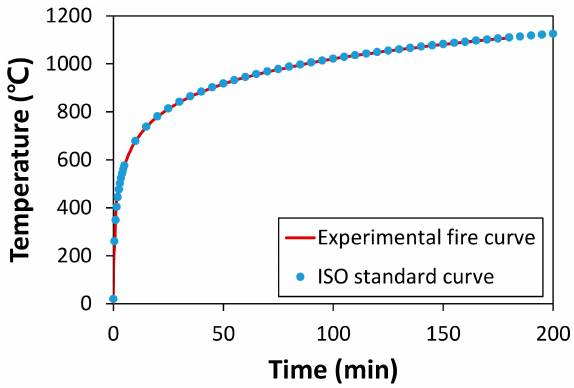
Figure 3. Comparison of actual fire test and ISO